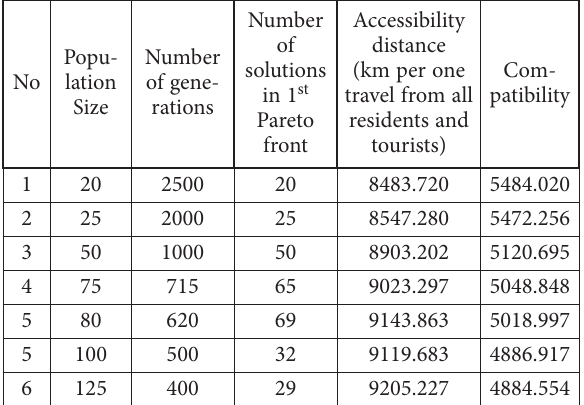
Table 3. Outcome of parameter settings of the